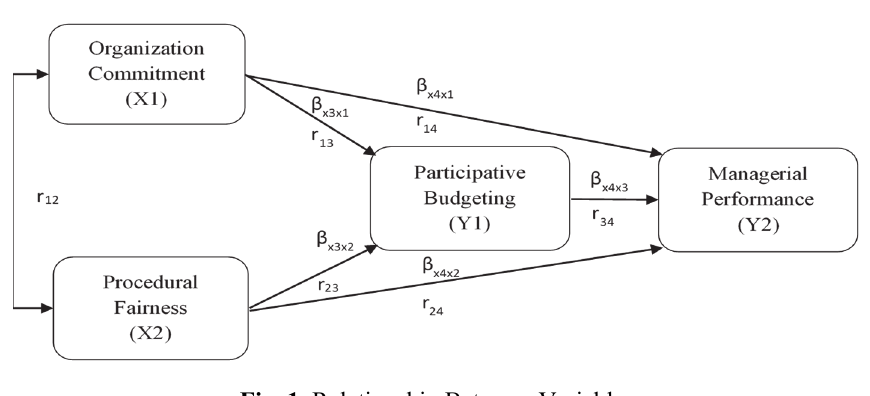
Fig. 1. Relationship Between Variables